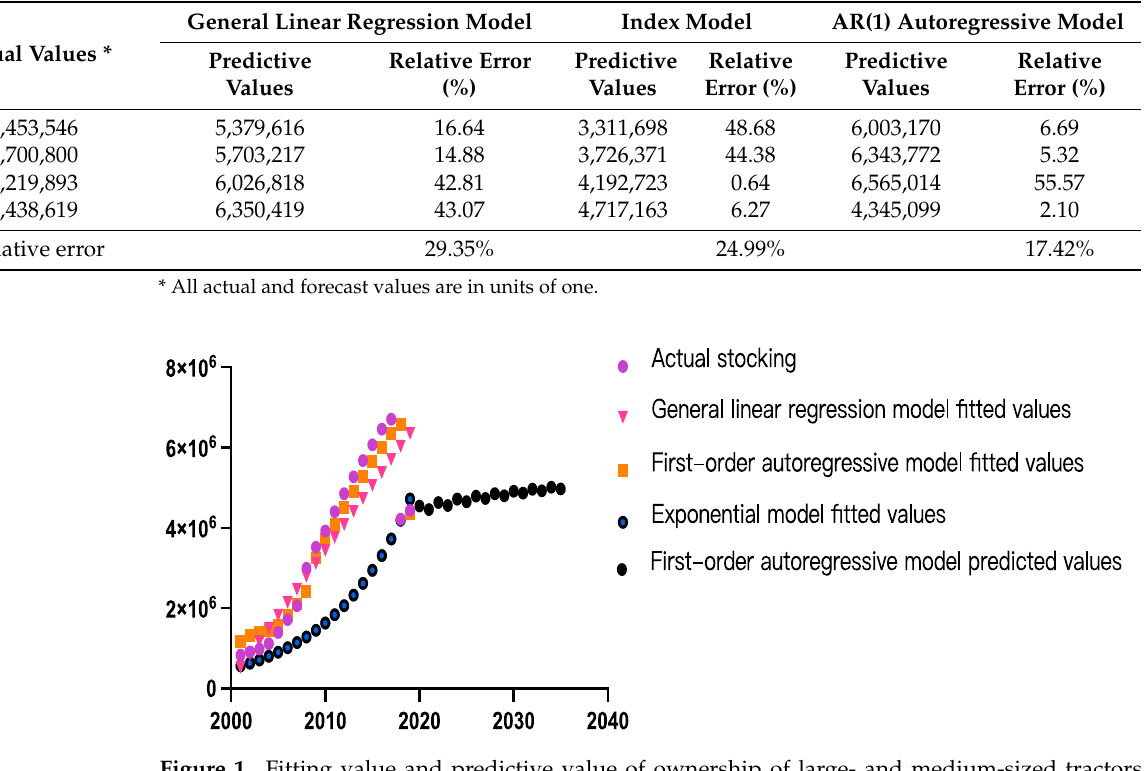
Table 4. Prediction errors of three different models.